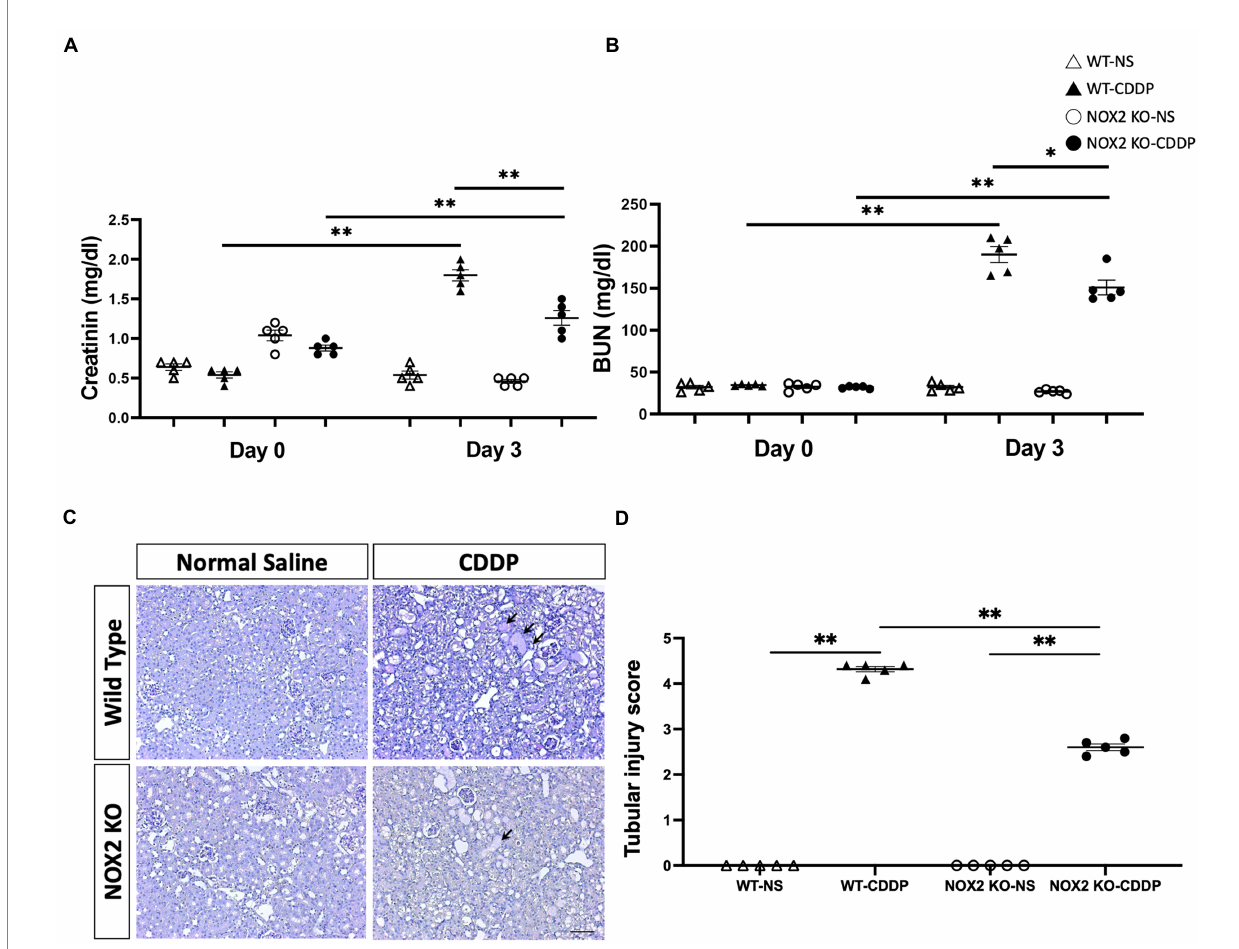
FIGURE 3 Mice with NOX2 deletion had milder cisplatin-induced AKI. (A) Serum creatinine levels indicated that NOX2-KO suppressed the cisplatin-mediated decrease in renal function. (B) BUN levels had a lower trend in NOX2 KO-CDDP mice compared with WT CDDP mice. (C,D) PAS staining of renal tubules revealed cisplatin-induced cast formation, tubular dilatation (black arrow), and tubular epithelial cell injury in WT CDDP mice. Quantitative analysis of PAS staining indicated NOX2 deletion suppressed the tubular injury score 3 days after cisplatin injection. Data represent the mean ± standard error of five mice per group. Scale bar = 100 μ